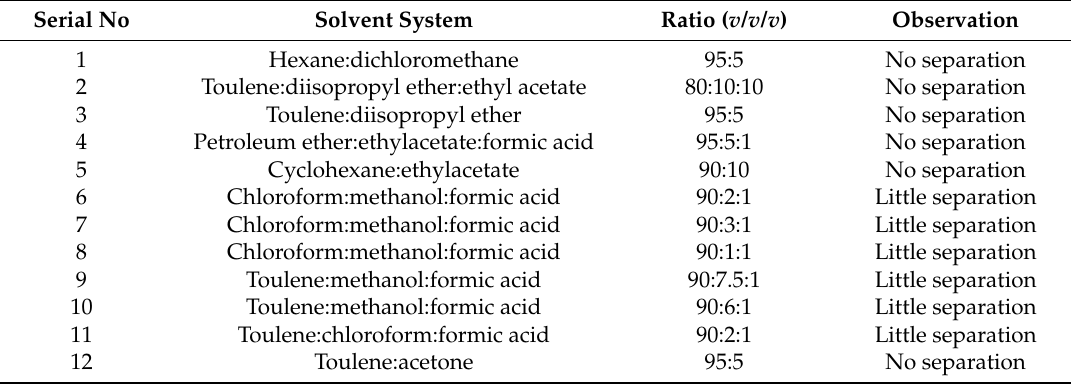
Table 2. Solvent system tried for separation of the phytoconstituents of essential oil.